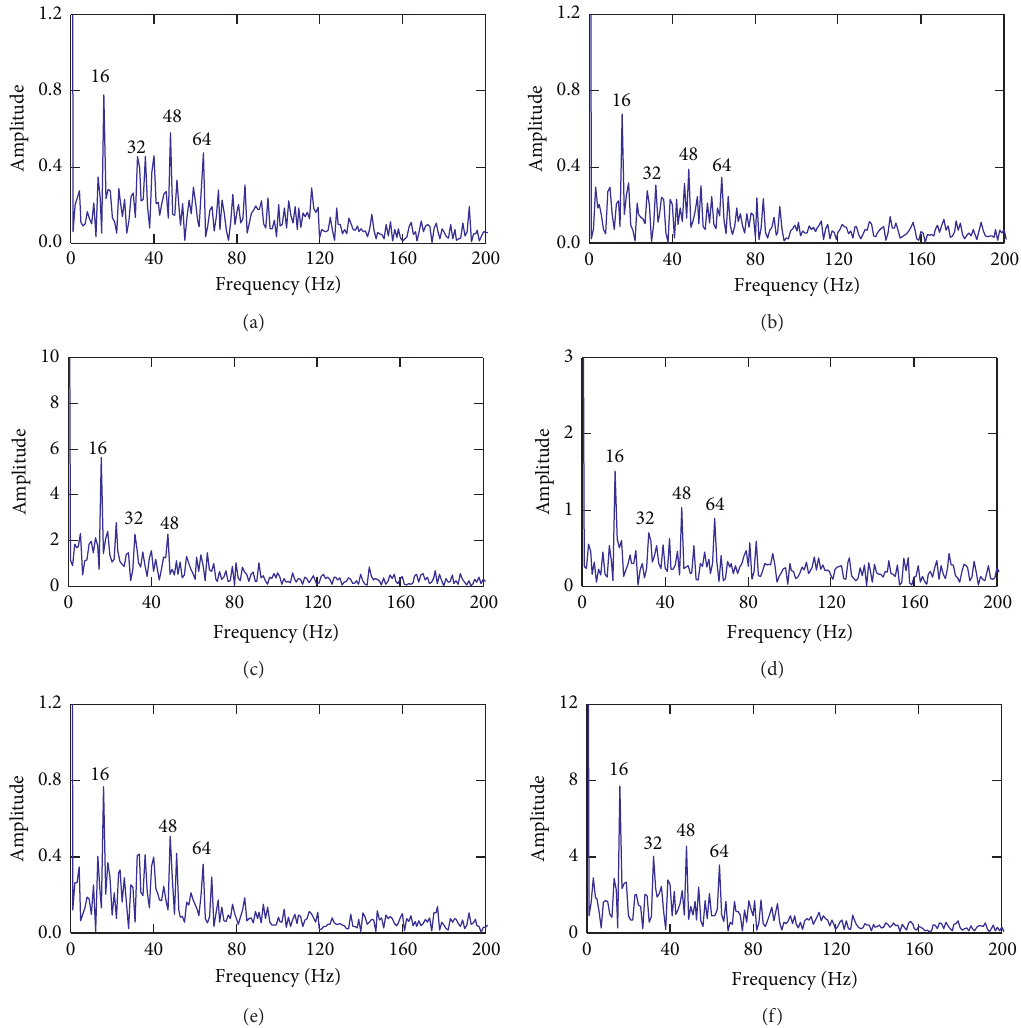
Figure 5: The results of simulation signal y ( t ) processed by (a) MG, (b) DIF, (c) MGPO, (d) MHPO, (e) ACDIF, and (f)